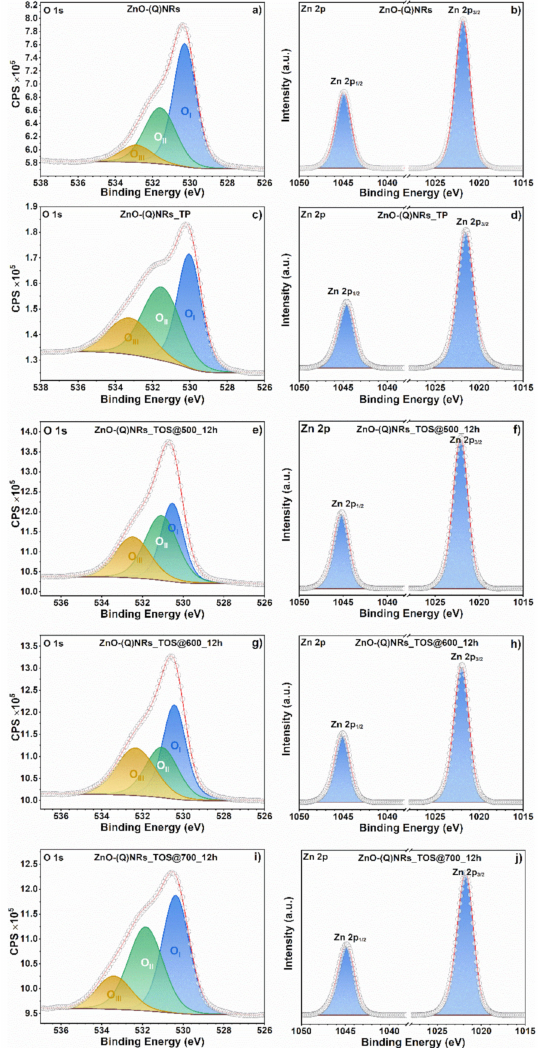
Figure 14. High-resolution XPS spectra of ZnO-(Q)NRs in the O 1s and background-subtracted Zn 2p spectral regions for pristine ZnO-(Q)NRs ( a , b ) temperature program (TP, light-off reaction) ( c , d ) and time-on-stream (TOS) reactions at ( e , f ) 500 ◦ C, ( g , h ) 600 ◦ C, and ( i , j ) 700 ◦